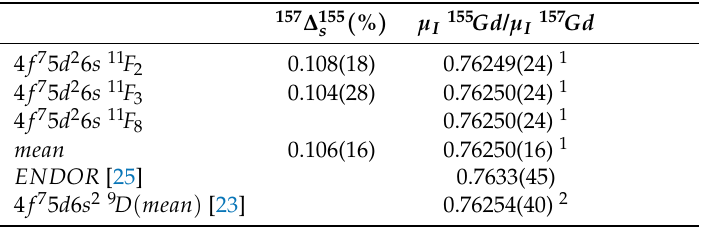
Table 4. Hyperfine anomaly and magnetic dipole moment ratios in